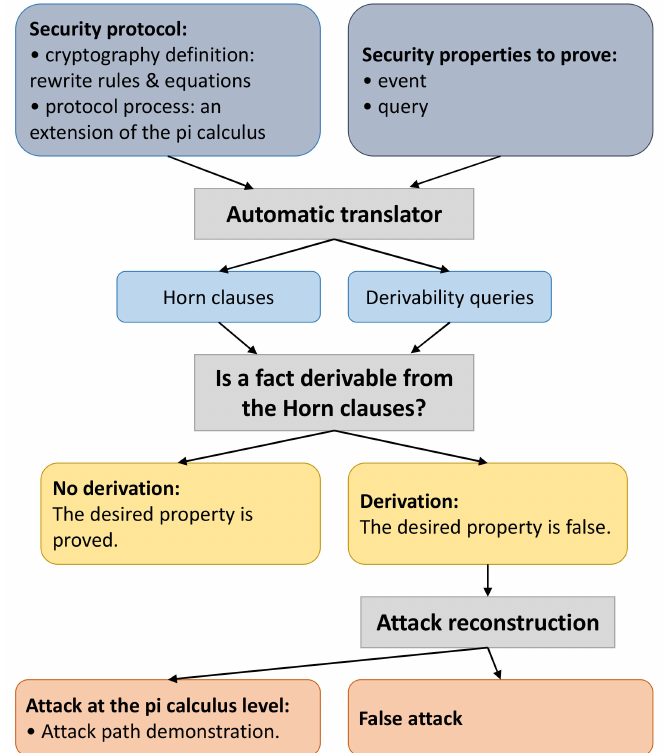
Figure 7. Structure and execution process of